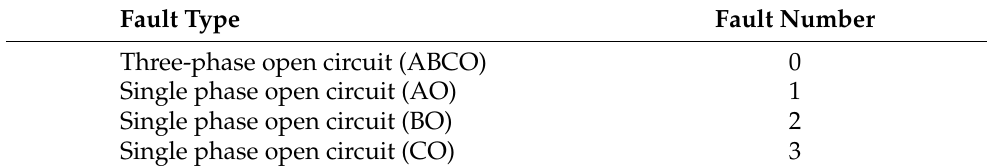
Table 3. Fault types and